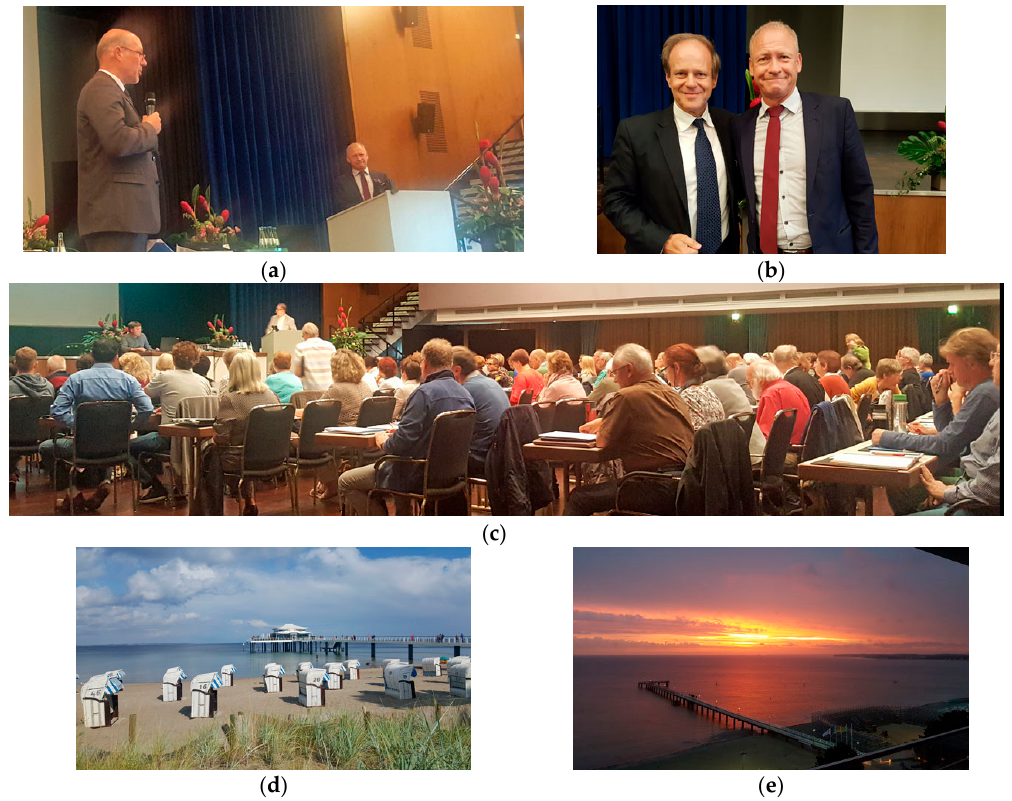
Figure 20. Acupuncture Congress: Germany ( a – e ). ( a ) Dr. Bernd Ramme (Chair of the DAA e.V., left) and PD Dr. Dominik Irnich (Chair of DÄGfA e.V.); ( b ) Professor Gerhard Litscher and PD Dr.